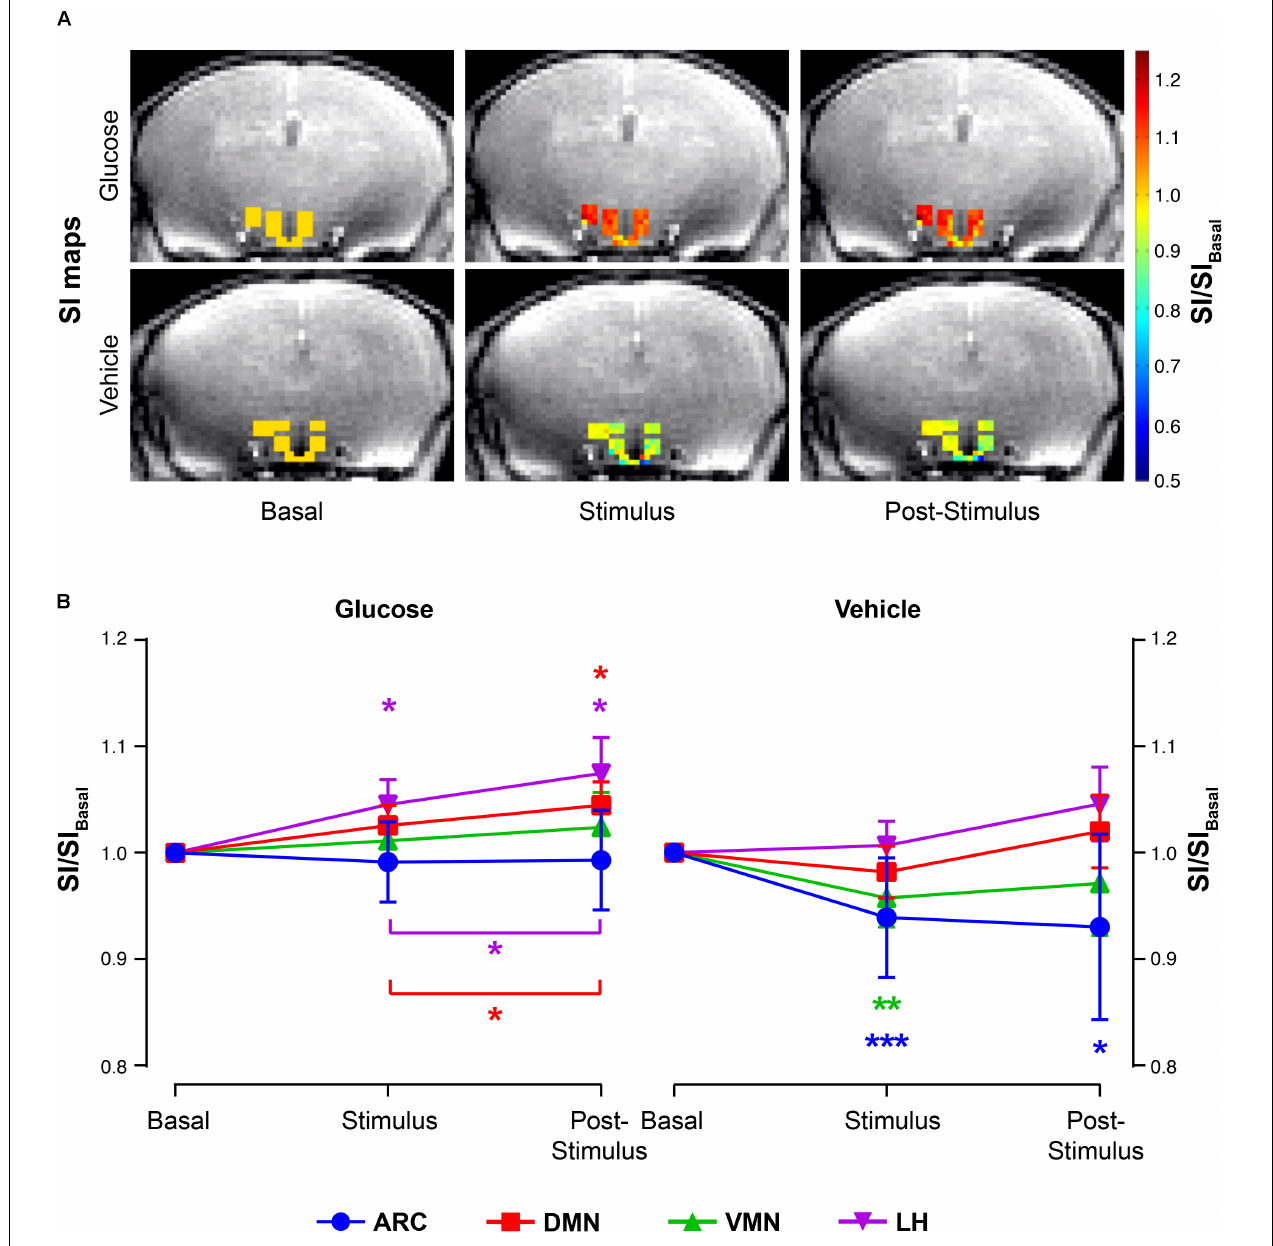
FIGURE 3 | T 2 ∗ W signal changes in the hypothalamic nuclei after the administration of glucose or vehicle to fasting mice. (A) Representative color maps of normalized-to-baseline T 2 ∗ W SI from representative glucose (top) and vehicle (bottom) mice, at basal conditions (left), immediately after stimulus (middle) or during the post-stimulus periods (right). Colored voxel values in the hypothalamus are superimposed to a cerebral T 2 ∗ W image across the same plane. (B) Mean SI/SI basal values of all voxels ( ± SEM) from the glucose (left) and vehicle (right) cohorts during the basal , stimulus and post-stimulus periods in the ARC, DMN, VMN and LH areas (in blue, red, green and purple, respectively) ( ∗ p < 0.05, ∗∗ p < 0.005, ∗∗∗ p <